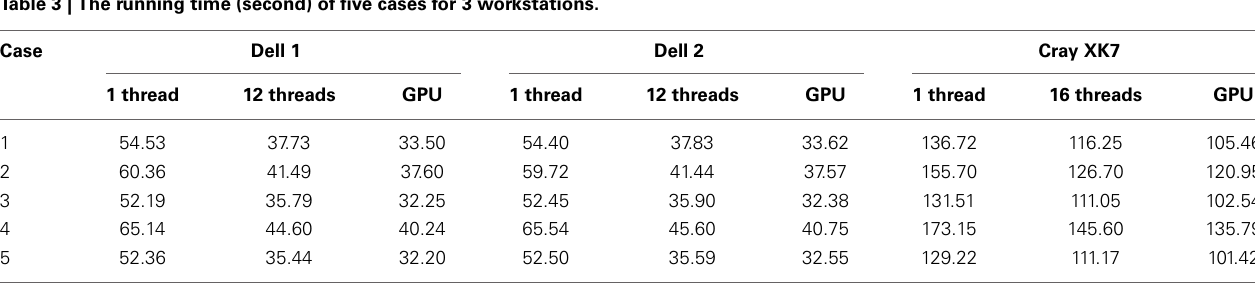
Table 3 | The running time (second) of five cases for 3